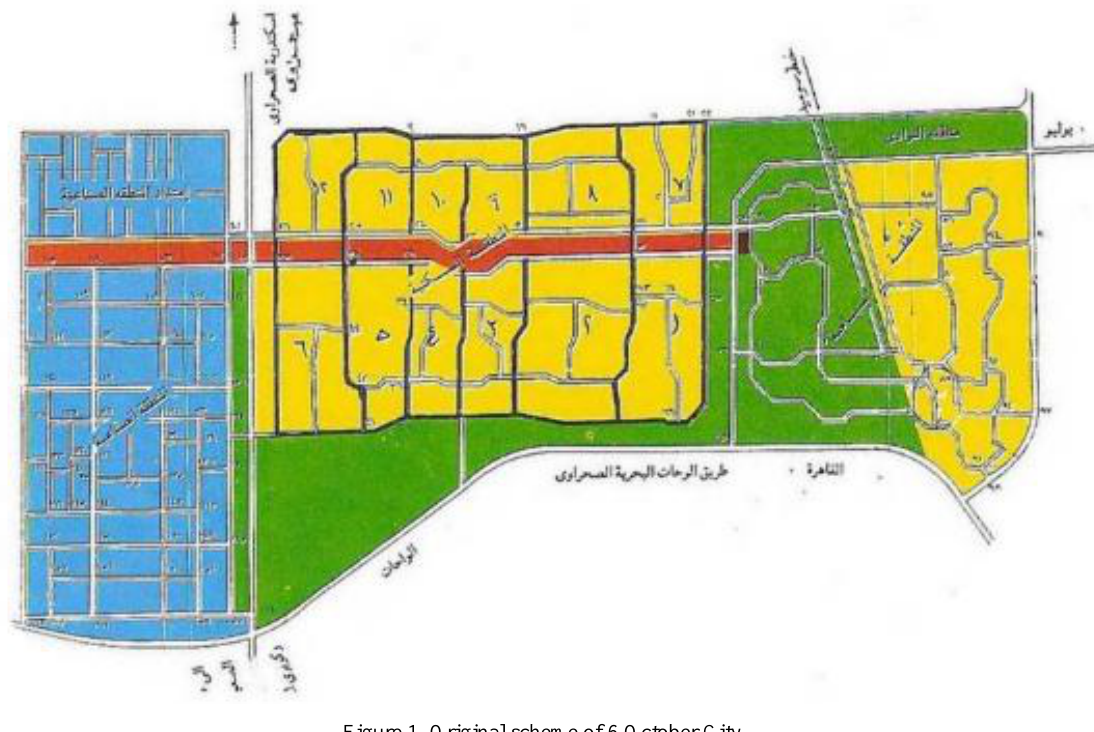
Figure 1. Original scheme of 6 October